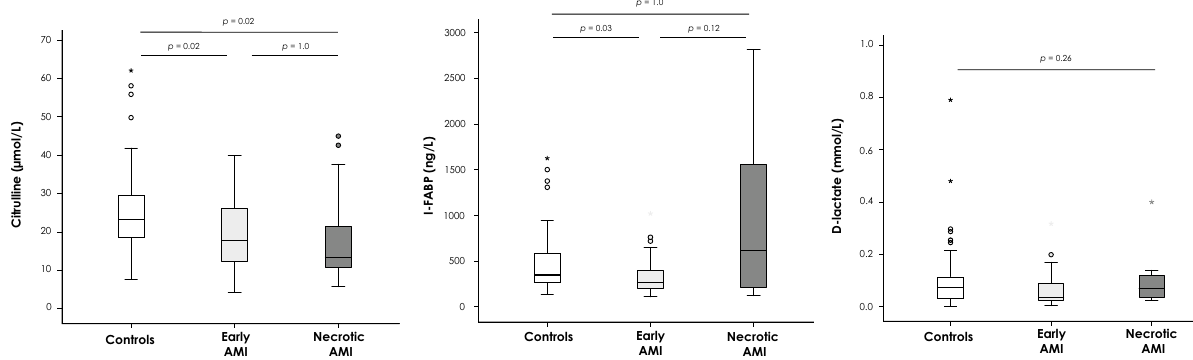
Figure 3. Citrulline, I-FABP, and d-lactate blood concentrations according to the severity of acute mesenteric ischemia (early or late—necrotic—ischemia). Abbreviations: AMI acute mesenteric ischemia, I-FABP intestinal fatty-acid binding protein. Comparison of acute abdominal pain controls (n = 79) and patients with early AMI (n = 36), and necrotic AMI (n = 14). Analyses were performed with the use of the Kruskal–Wallis test. When the result of a global test was significant ( p < 0.05), post hoc Bonferroni-corrected pairwise comparisons were performed. The horizontal line in the boxes represents the median, and the bottom and top of the boxes, the 25th and 75th percentiles, respectively. I bars represent the upper adjacent value (75th percentile plus 1.5 times the interquartile range) and the lower adjacent value (corresponding formula below the 25th percentile). Outliers are represented by dots (outside of the I bars) and extreme outliers by asterisks (outside of the 75th percentile plus 3 times the interquartile range, or the 25th percentile minus 3 times the interquartile